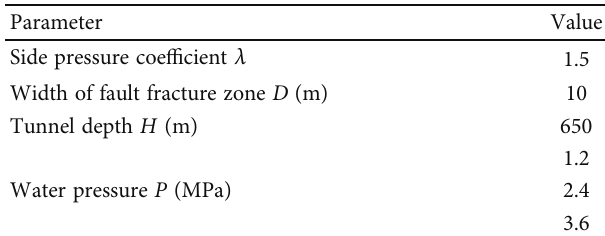
Table 3: Calculation parameters for water pressure